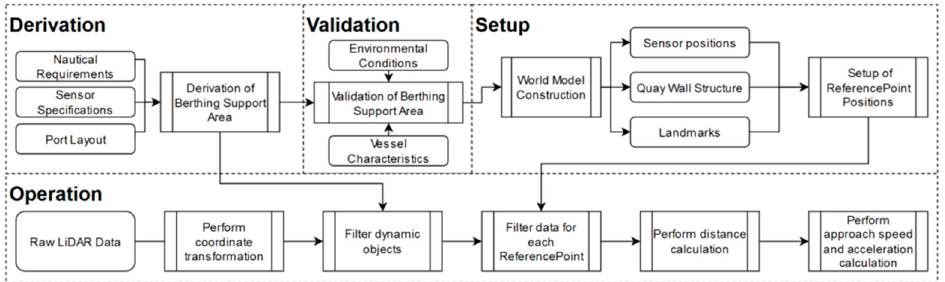
Figure 4. The BSA derivation and operation process. The former one includes set setup and validation to gain Reference Points, while the latter summarizes the process for the Reference Points to be used to determine the distance and speed